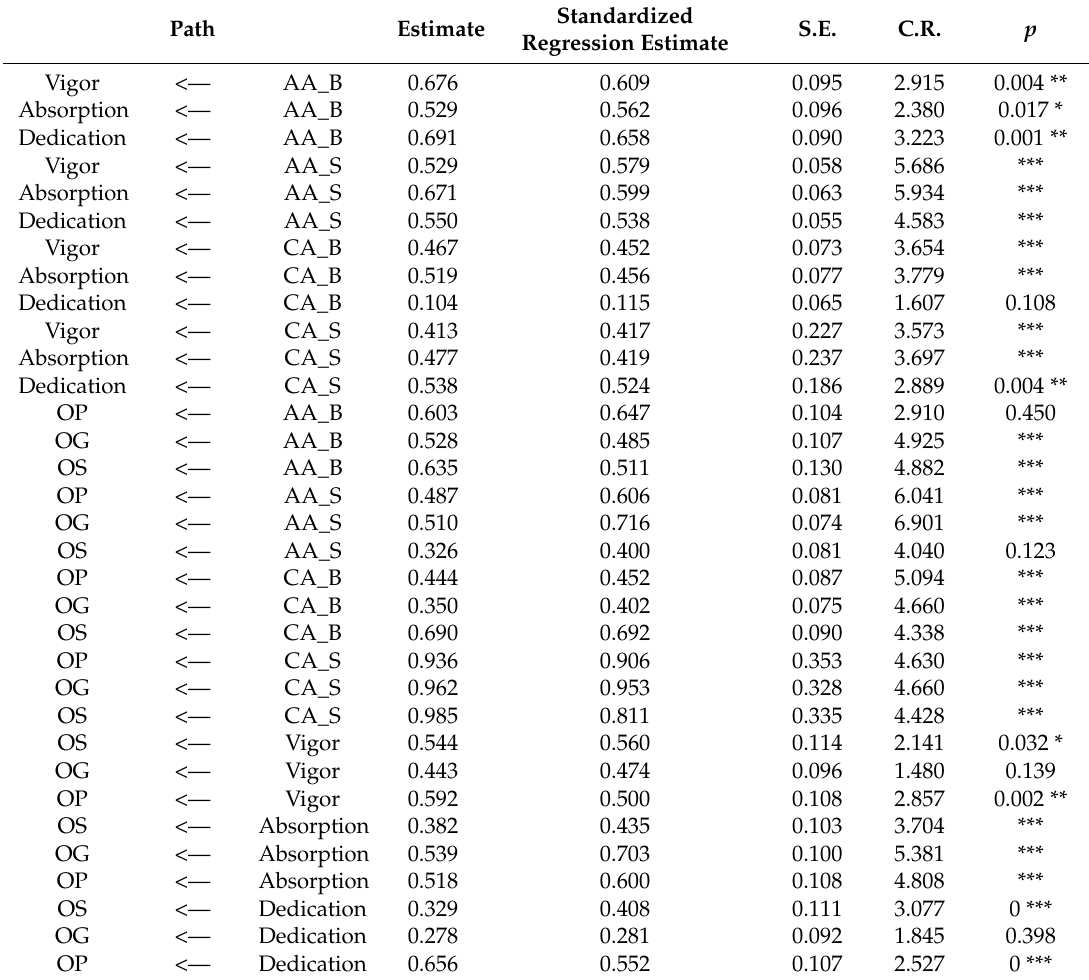
Table 10. Results of regression